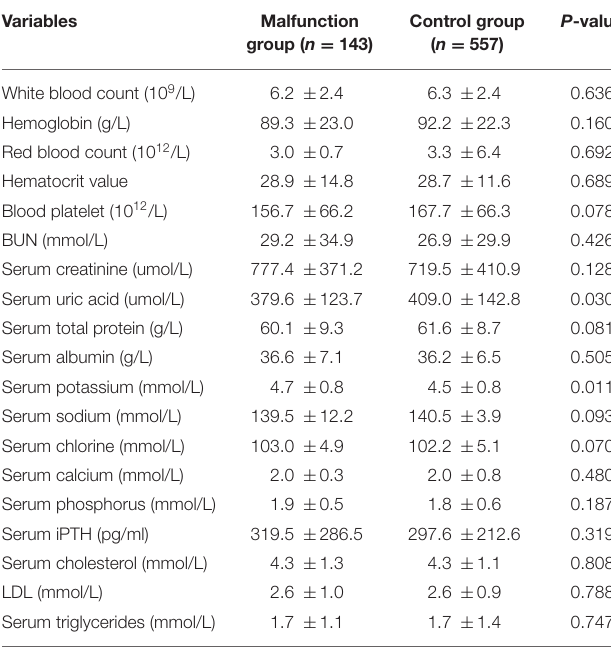
TABLE 1 | Demographic characteristics and clinical data of the study population. TABLE 2 | Laboratory data before PD catheter